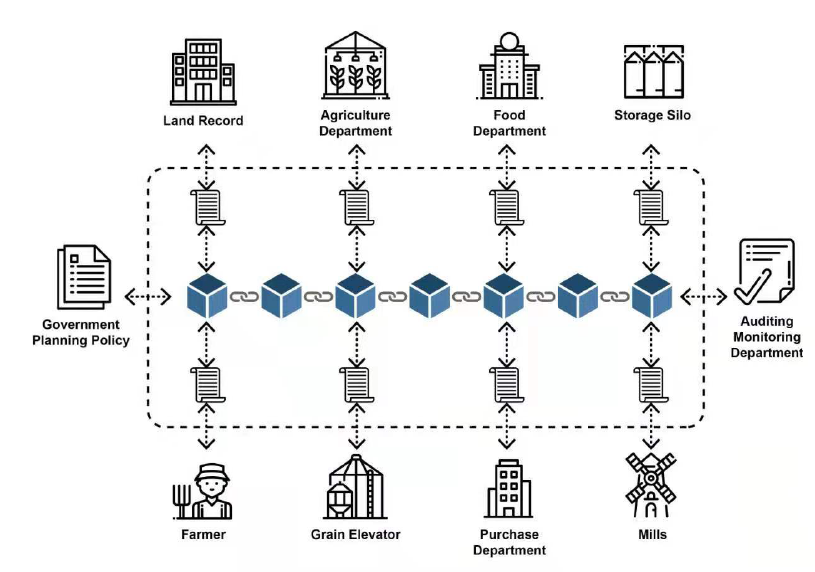
Figure 3. Logical overview of the proposed blockchain-based